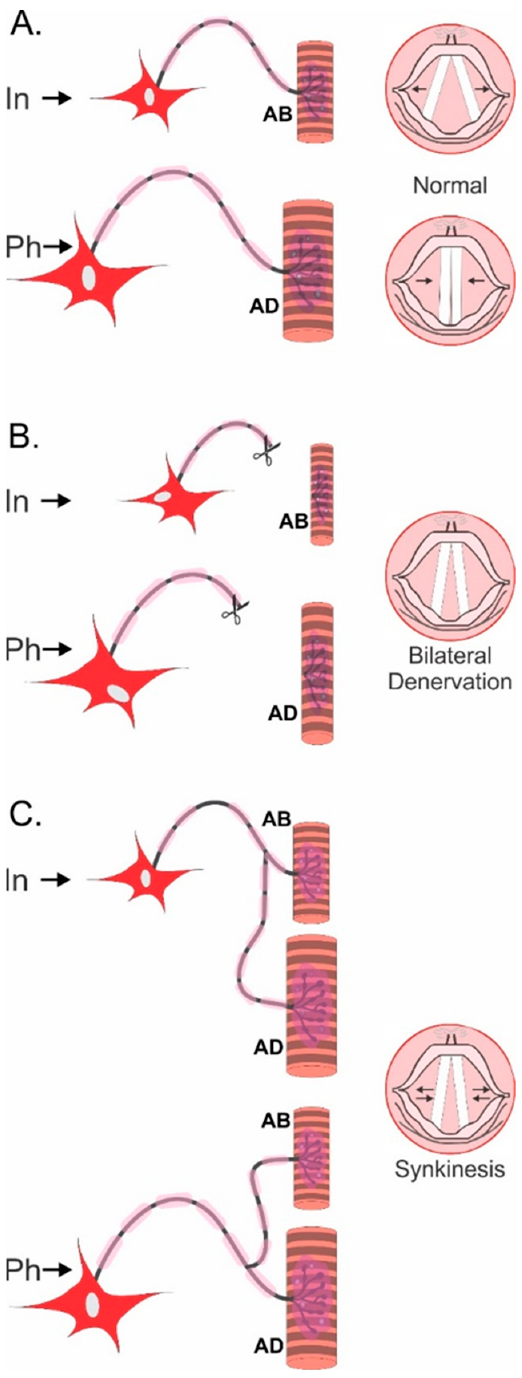
Figure 5. Non-selective reinnervation of muscles after peripheral nerve surgery. The diagrammatic representation of the innervation of the intrinsic abductor (AB) and adductor (AB) muscles of the vocal cords by inspiration and phonation (speaking) in normal ( A ), denervated ( B ), and reinnervated ( C ) intrinsic muscles. The large and small motoneurons innervating the AB and AD muscles, respectively, represents the 4:1 ratio of the number of the motoneurons innervating the AB and AD muscles. After bilateral denervation, the vocal cords do not close during phonation so that speech is severely impaired ( B ). After surgical repair of the laryngeal nerve, the axotomized motoneurons randomly reinnervate the AB and AD muscles ( C ) with the result that the vocal cords are effectively paralyzed in a position of openness that disallows effective speech. Adapted from [104].